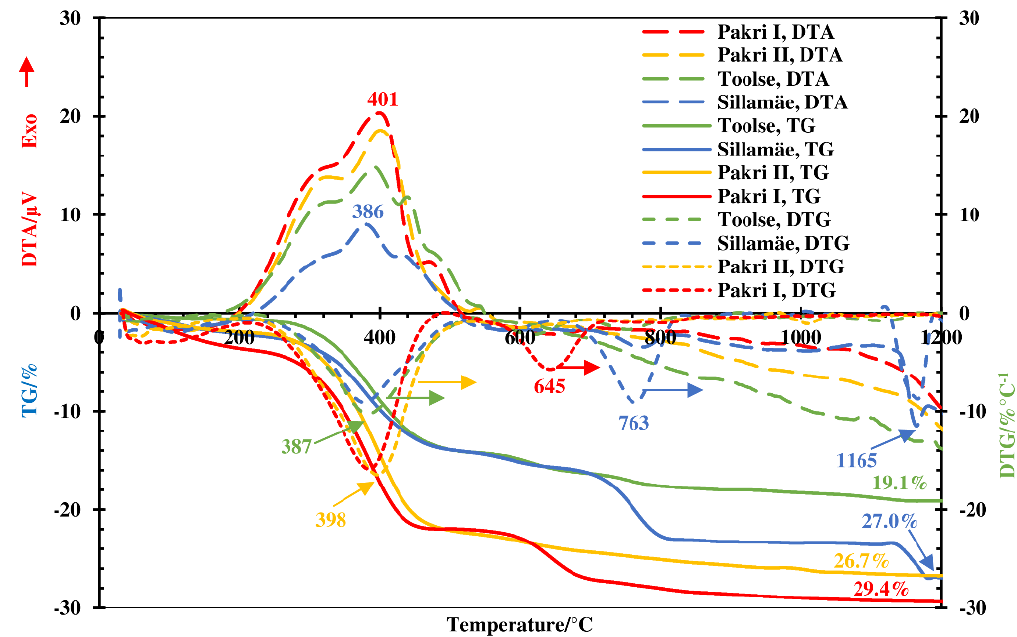
Processes 2022 , 10 , 1986 7 of 19